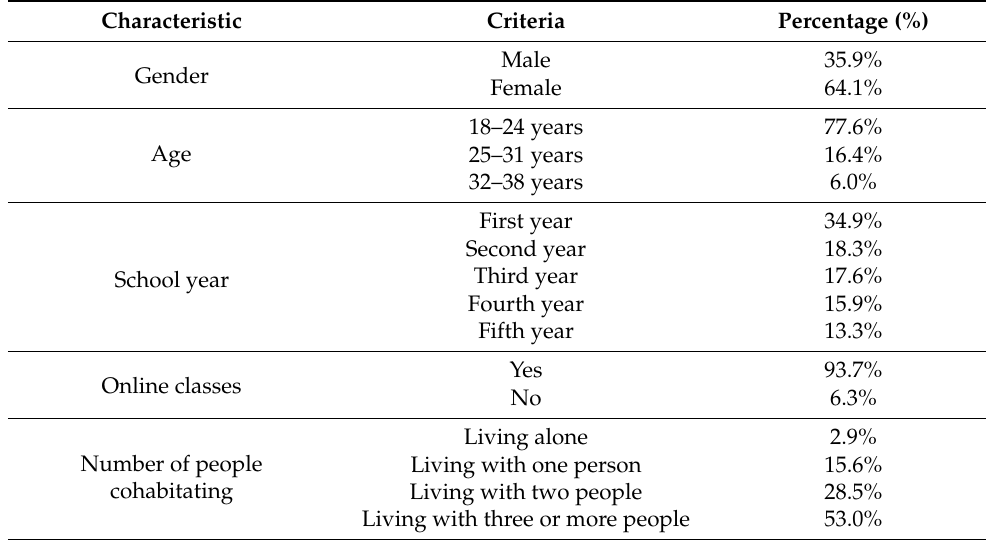
Table 1. Participants’